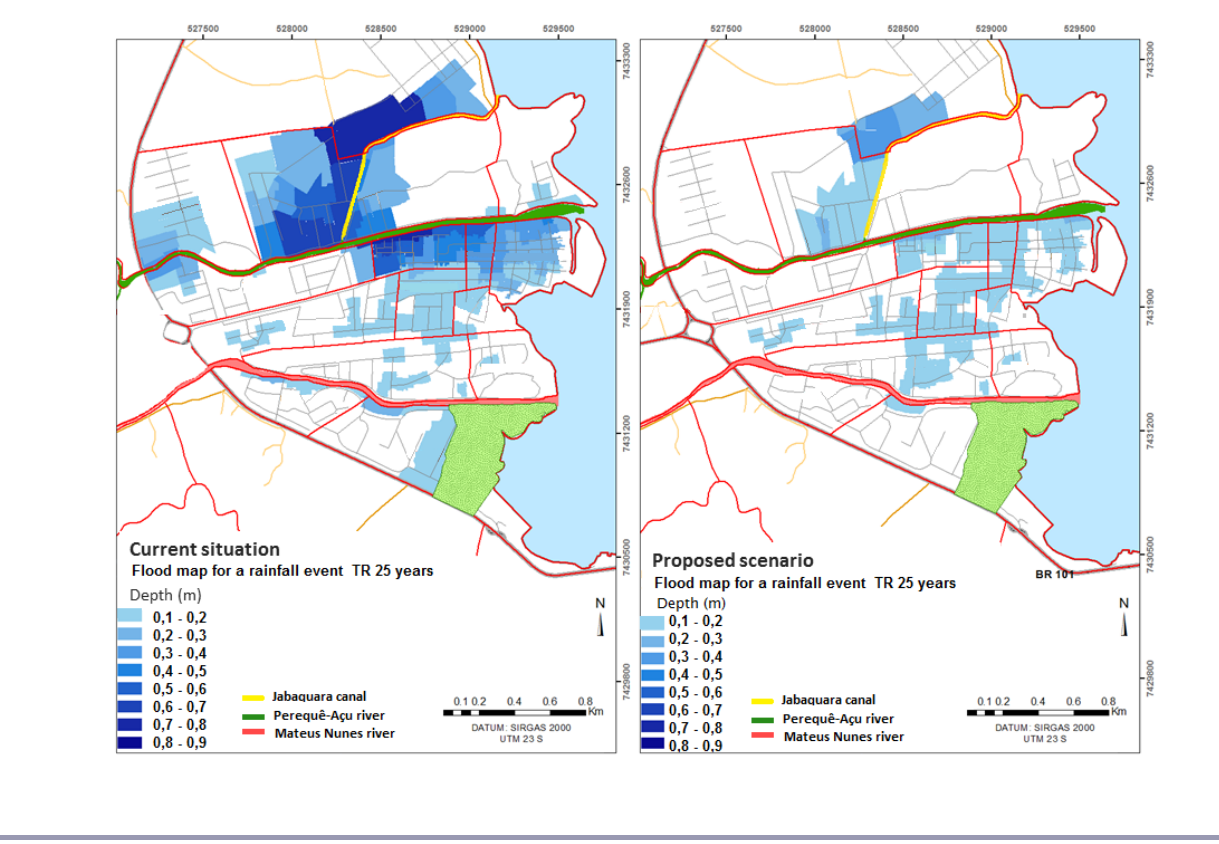
Fig. 4 . Flood maps for the current situation (left) and proposed scenario (right) for a time recurrence (TR) of